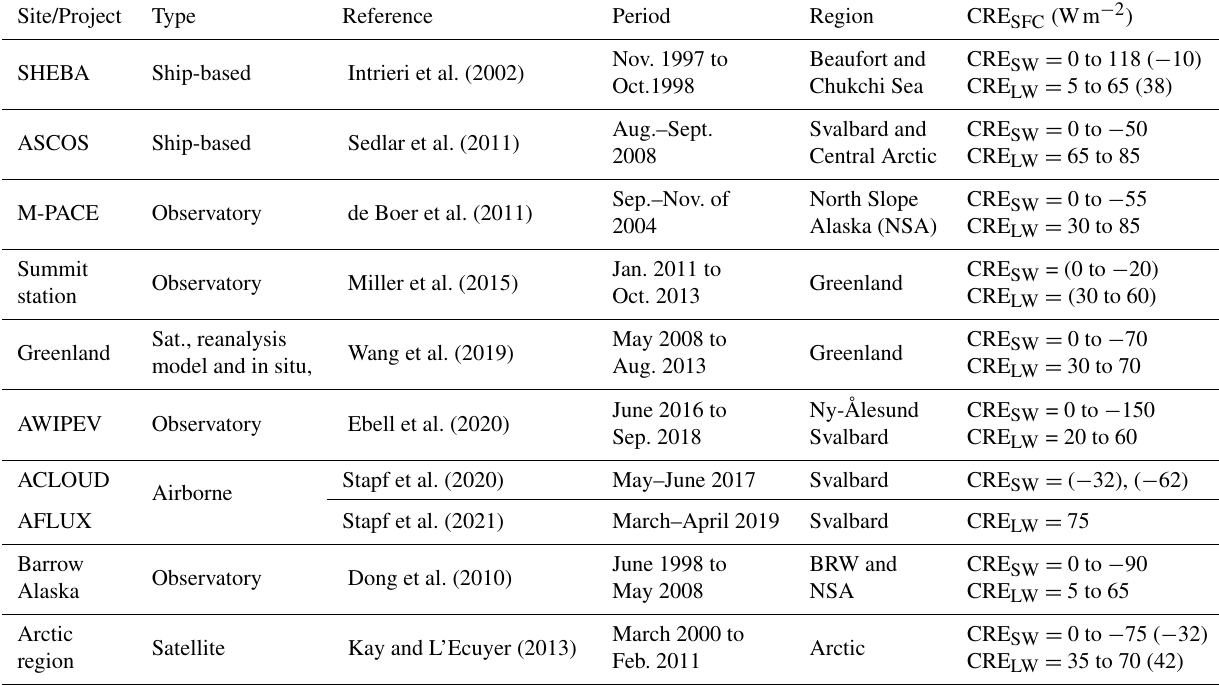
Table 4. Summary of literature comparison of the cloud radiative effect (CRE) at the surface (CRE SFC ) from different studies. Values in parentheses indicate the mean for the entire